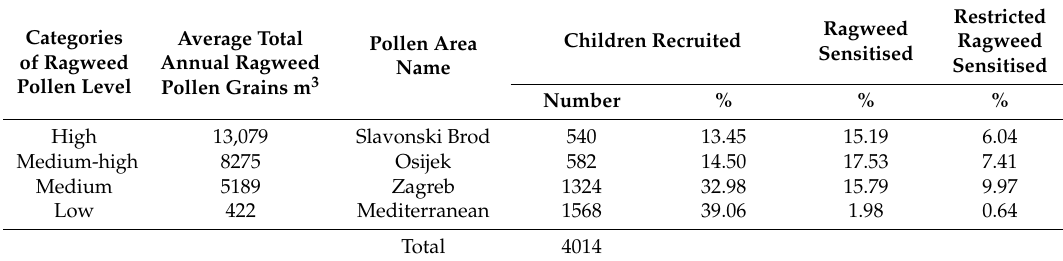
Table 2. Ragweed pollen levels and children